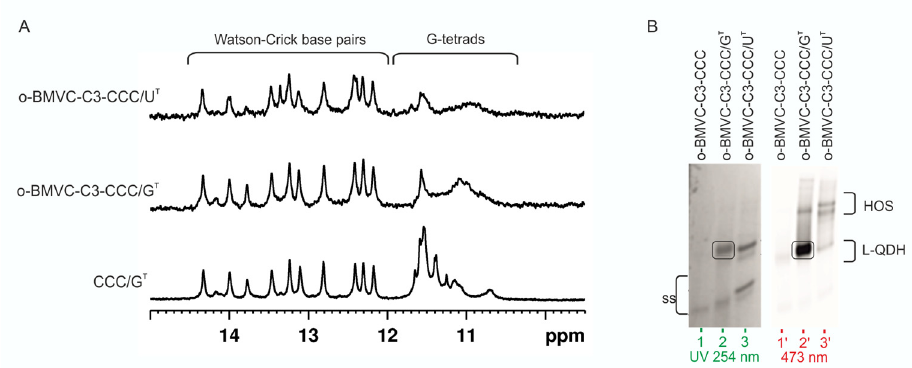
Figure 10. The imino region of the 1 H NMR spectra of o-BMVC-C3-CCC/G T , o-BMVC-C3-CCC/U T , and CCC/G T recorded in 90% H 2 O/10% D 2 O ( v / v ); 25 °C ( A ). Migration of o-BMVC-C3-CCC, o-BMVC-C3-CCC/G T , and o-BMVC-C3-CCC/G T in non-denaturing PAGE 20%. Gel was visualized by UV light (254 nm) to detect all RNAs ( B , left ), and the same gel was exposed to 473 nm light to visualize the RNA structure adopting the ligand–quadruplex domain ( B , right ) in the presence of 50 mM KCl, 10 mM potassium phosphate and 0.1mM EDTA, pH 6.8.